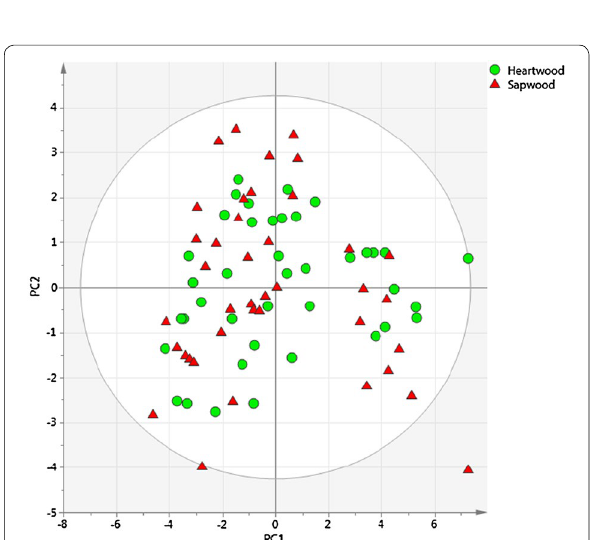
Fig. 8 PCA score plot describing the MC with adjusted coordinates (PC1 and PC2) for maximum variation between the replicates. Replicates close in space have a similar MC. The replicates are coloured according to the parameters of heartwood and